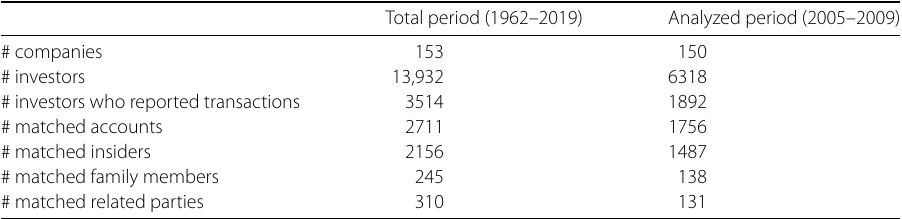
Table 1 Summary statistics for insider data over all the years from April 1962 and November